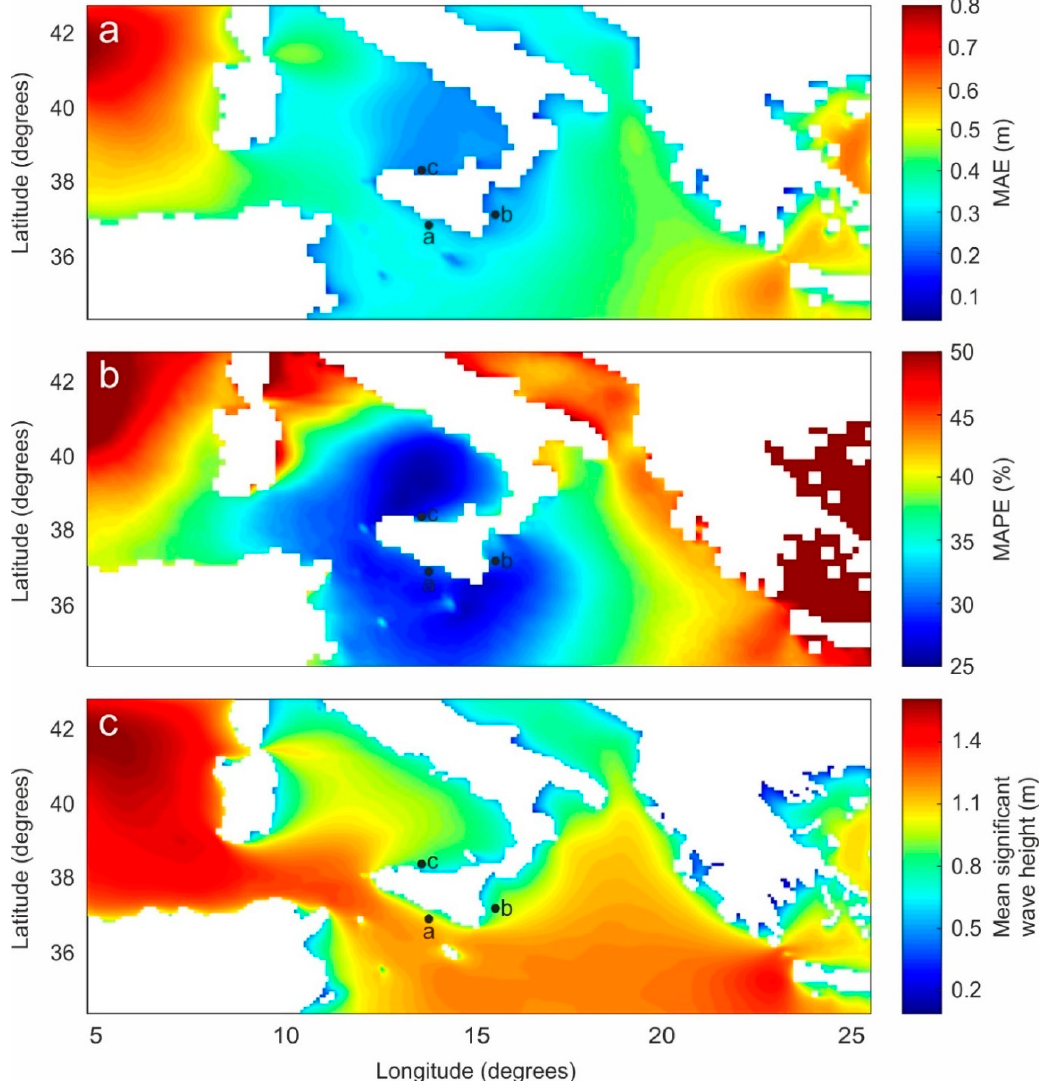
Figure 6. Spatial distribution of ( a ) mean absolute error (MAE), ( b ) mean absolute percentage error (MAPE), and ( c ) mean significant wave height computed during the interval 2010–2017. The black dots with labels “a,” “b,” and “c” indicate the locations of the grid cells, which the cross-plots in Figure 7 are referred to.